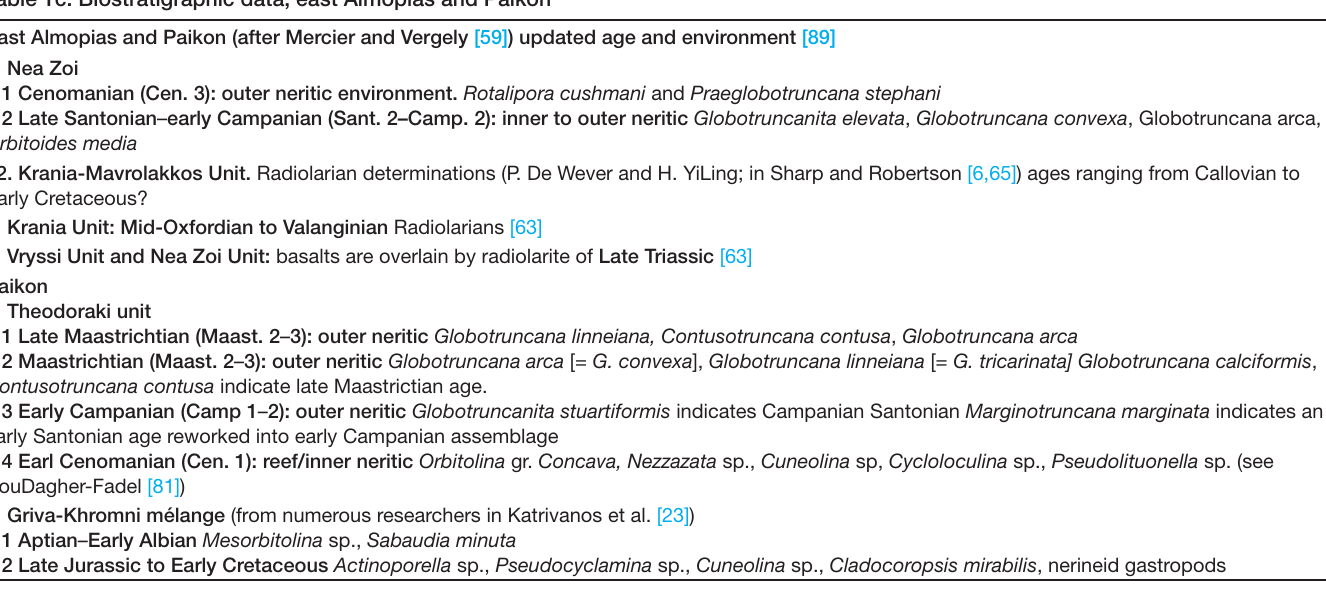
Table 1c. Biostratigraphic data, east Almopias and Paikon East Almopias and Paikon (after Mercier and Vergely [59]) updated age and environment